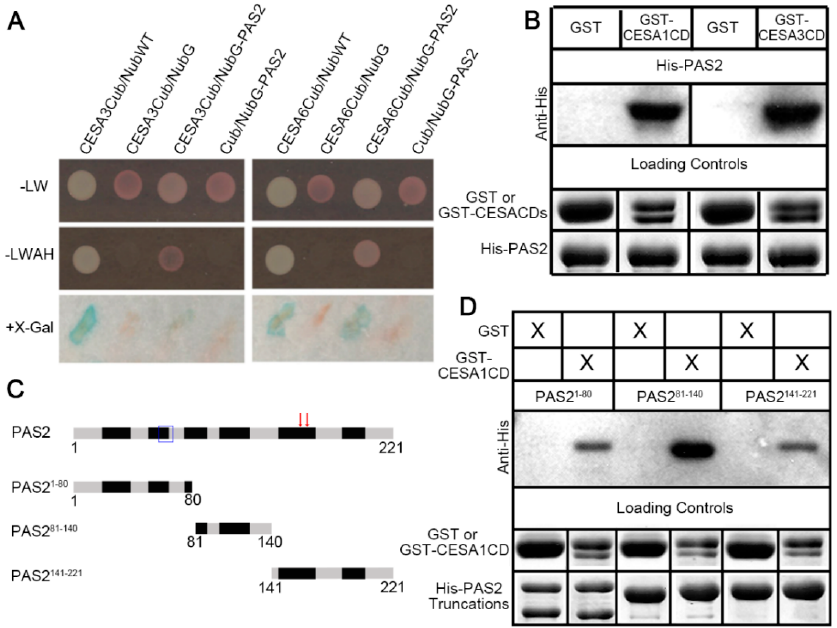
Figure 1. PAS2 interacts with multiple primary CESAs. ( A ) Split Ubiquitin yeast two hybrid analysis shows positive interactions between PAS2 and both CESA3 and CESA6. Interactions were selected on Leu (L), Trp (W), Ala (A) and His (H)-dropout medium. 5-Bromo-4-chloro-3-indolyl- β -D-galactopyranoside (X-Gal) was added for the detection of β -galactopyranoside activity. Cub vector alone serves as a negative control for NubG-PAS2. NubWT and NubG vectors serve as positive and negative controls, respectively, for CESA-Cub. ( B ) In vitro pull-down assay showing that PAS2 protein interacts with the central domains (CD) of CESA1 and CESA3. Both GST-CESA1CD and GST-CESA3CD co-precipitated with His-PAS2. Empty GST beads were used as negative controls that did not pull down His-PAS2. ( C ) Schematic graphs showing domain structure of PAS2. Black squares represent putative transmembrane domains. Blue box highlights the tyrosine phosphatase-like domain and red arrows represent the position of dehydratase’s catalytic residue Y156 and E163. ( D ) All three PAS2 truncations interact with the central domain of CESA1. GST-CESA1CD co-precipitated with all three truncated proteins tagged by His; Empty GST beads were used as negative controls.